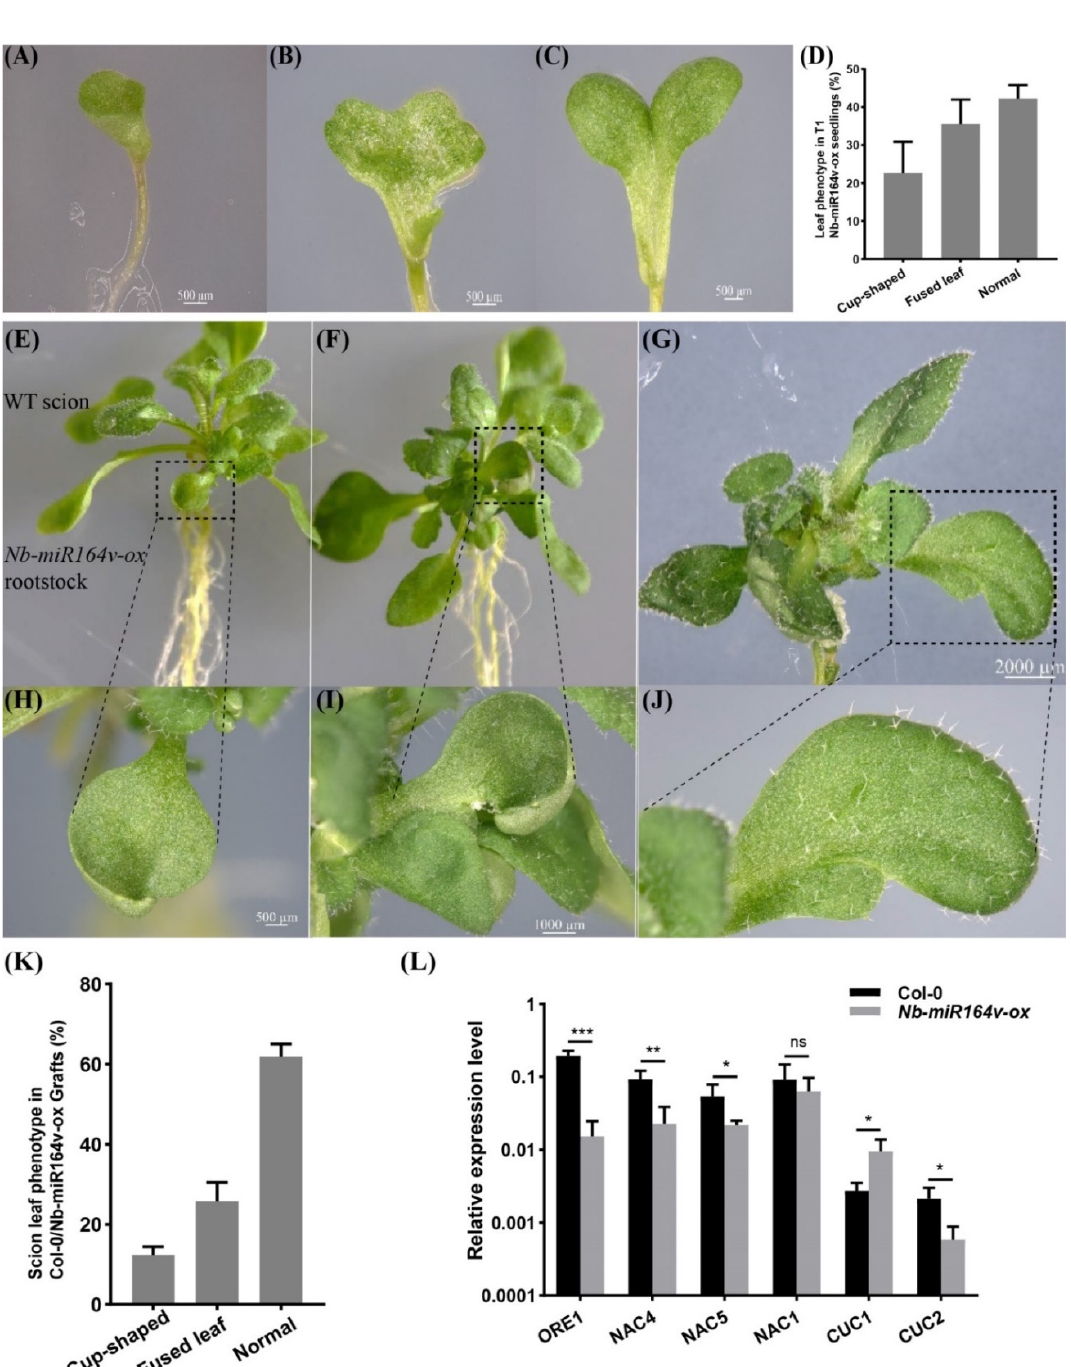
Figure 4. Phenotypic changes in a scion by root-to-shoot transmissible Nb-miR164v . (A–D) Overexpression of Nb-miR164v driven by a ubiquitin10 promoter in Arabidopsis , resulting in leaf defects such as the cup-shaped cotyledon ( A ), fully fused cotyledon ( B ) and partially fused cotyledon ( C ). ( D ) The percentage of Nb - miR-164v-ox seedlings showing the leaf phenotype as in ( A – C ). The bars represent the means and standard deviations of the two experiments ( N = 50 in each experiment). ( E – G ) The WT Arabidopsis was used as a scion and grafted to the above plants with leaf defects. ( H – J ) Cup-shaped and partially fused leaves from the scion. Note that not all the leaves from the scion showed defects. ( K ) The percentage of grafts showing the altered leaf phenotype. The bars represent the means and standard deviations of three experiments ( N = 15 in each experiment). ( L ) Expression of Nb-miR164v targets in the scion leaves. The bars represent the means and standard deviations of six replicates (three biological replicates, each with two technical replicates). *, **, and *** indicate p < 0.05, <0.001, and <0.0001, respectively.